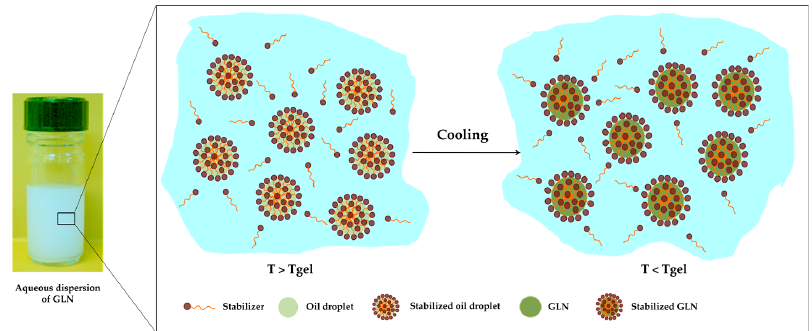
Figure 6. Schematic representation of GLN dispersion.